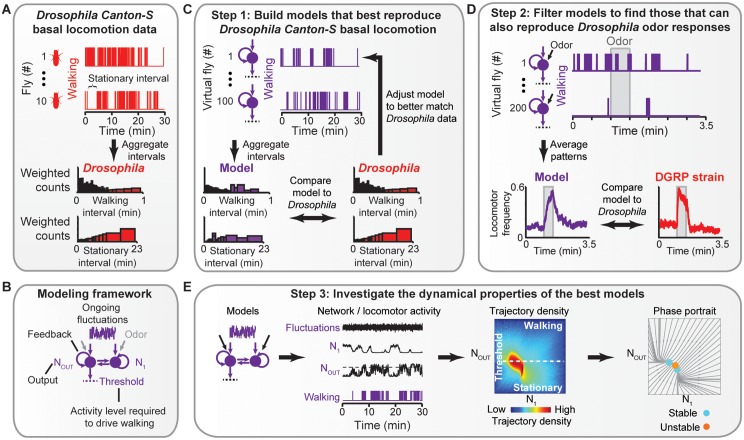
Workflow for generating and analyzing neural network models.(A) Basal locomotor patterns (filtered as in Fig 1D) are shown for two of ten Canton-S flies recorded for 30 min each. A stationary interval is highlighted for fly number ten. From these data, walking and stationary interval durations are aggregated and represented using weighted variable-width histograms for walking (top) and stationary (bottom) intervals. (B) A Continuous-Time Recurrent Neural Network (CTRNN) modeling framework used to investigate AS network dynamics. Models included up to five neurons, Gaussian noise inputs representing ongoing activity fluctuations, reciprocal and recurrent connections, odor inputs, and an output threshold to define the locomotor state of the virtual fly. (C) In the first step, a stochastic optimization approach is used to generate models that best reproduce Drosophila basal locomotor statistics. Locomotor statistics generated by a given model for 100 trials (virtual flies) are aggregated and compared to Canton-S strain data. The parameters for this model are then adjusted to reduce the difference from Canton-S data. This process is performed iteratively. (D) In the second step, odor inputs are added to the best previously generated models. For each model the strength of these inputs and the output threshold are adjusted iteratively to reduce the Root-Mean-Square Error (RMSE) between the model’s odor impulse locomotor pattern averaged across 200 trials (virtual flies) and a Drosophila strain’s odor impulse locomotor pattern averaged across ~200 flies. (E) In the third step, models that could match both Canton-S basal walking statistics and DGRP strain odor impulse locomotor patterns are characterized by the number of times specific neural activity levels are observed (‘Trajectory density’) color-coded from very frequent (dark red) to very rare (dark blue), and the tendency of neural activity, in the absence of fluctuations, to move toward (‘Stable’, cyan) or away from (‘Unstable’, orange) equilibrium activity levels (‘Phase portrait’). In each Trajectory density plot and Phase portrait, the bottom-left corner represents the lowest neural activity values.